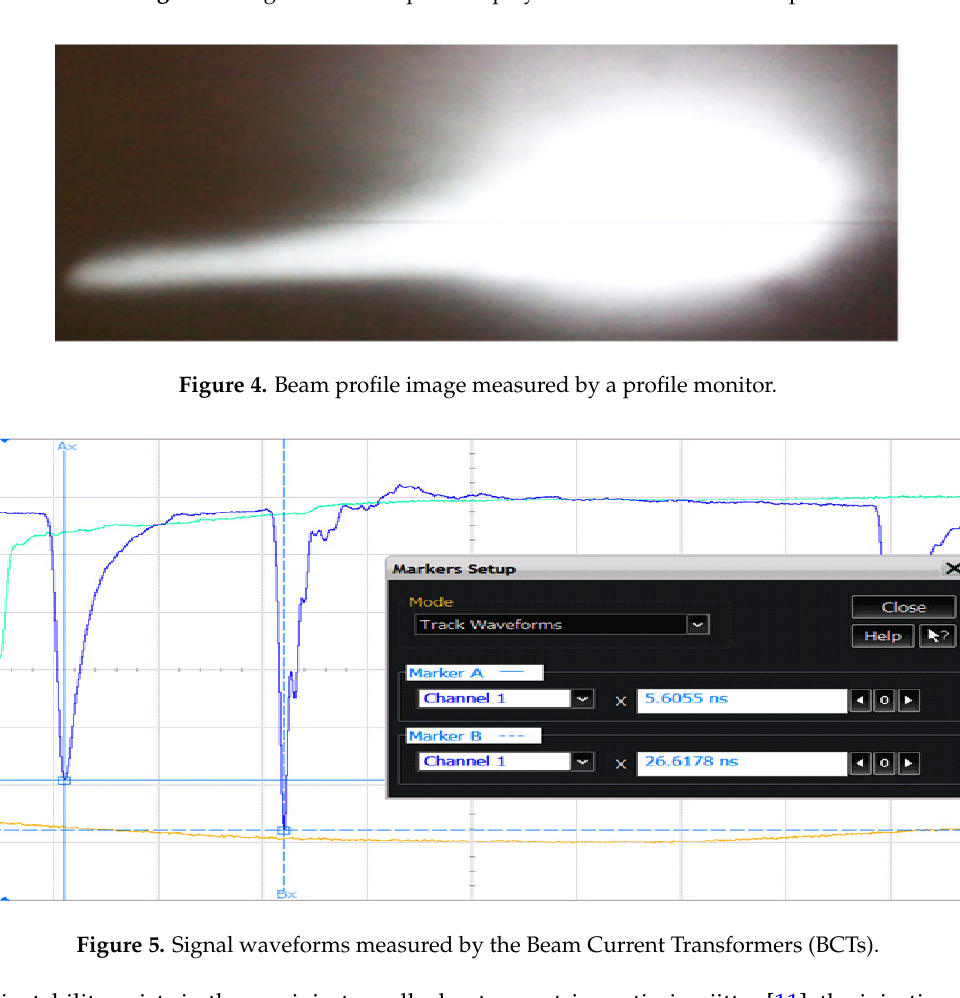
Figure 3. Single waveform picked up by a BPM with an oscilloscope.